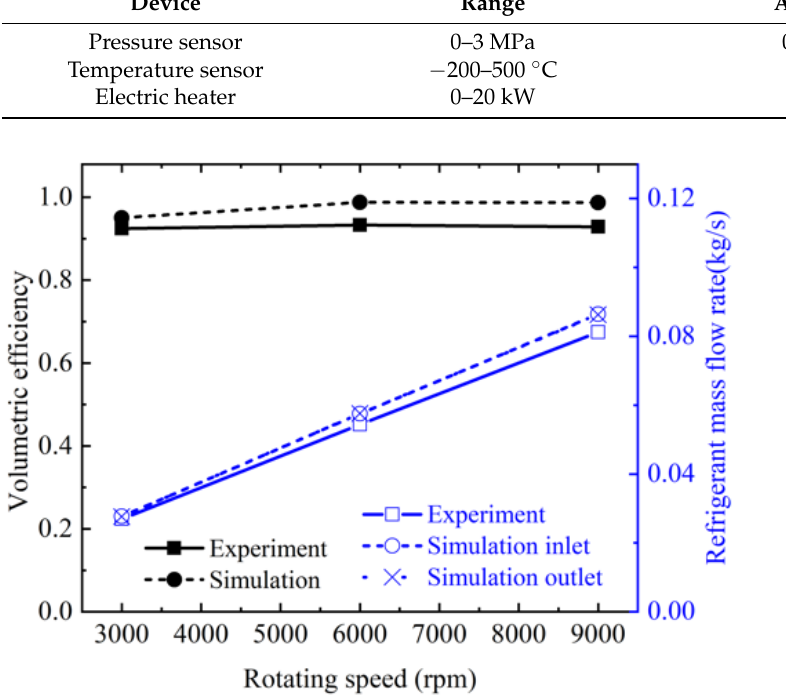
Figure 7. Variations in the volumetric e ffi ciency and mass fl ow rate of the refrigerant.